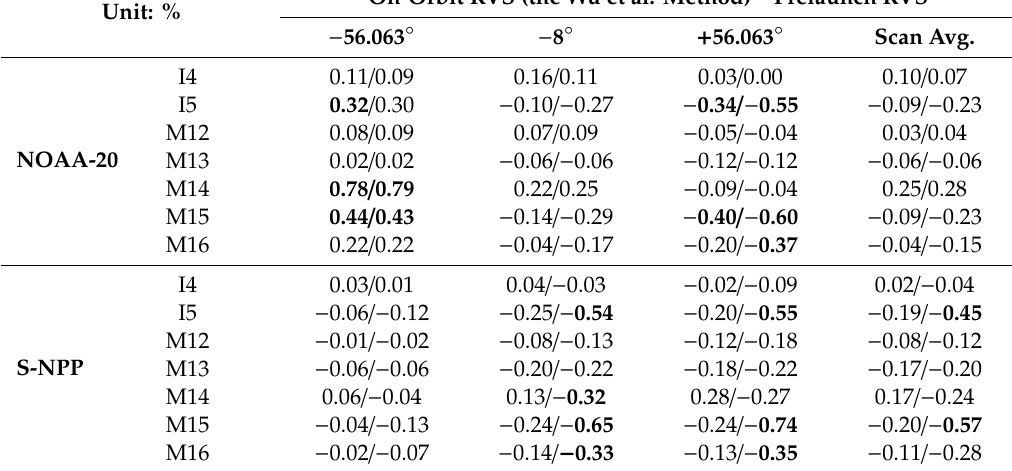
Table 4. NOAA-20 and S-NPP band-averaged di ff erences between the Wu et al. method derived on-orbit RVS and prelaunch RVS over scan angles at − 56.063 ◦ (EVBOS), − 8 ◦ (OBCBB AOI), + 56.063 ◦ (EVEOS), and averaged over the entire EV scan (Scan Avg.), for HAM-A and HAM-B. Cases with di ff erences exceeding ± 0.3% are